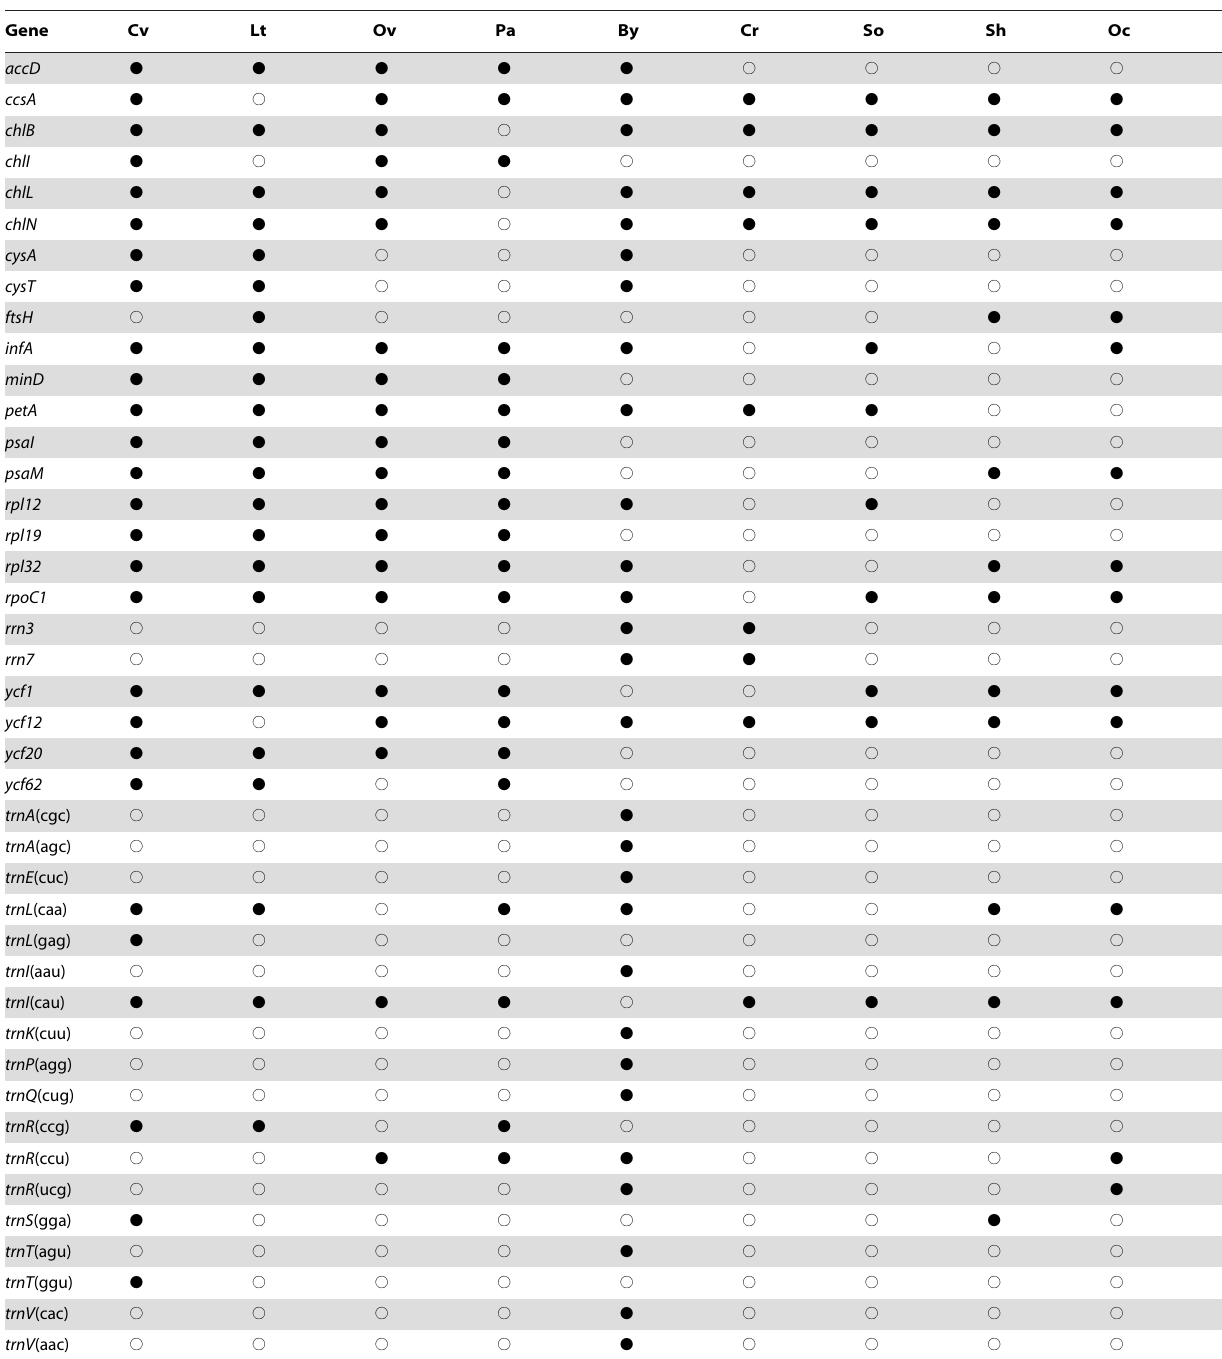
Table 2. Gene Content in B. hypnoides and Other UTC Algal